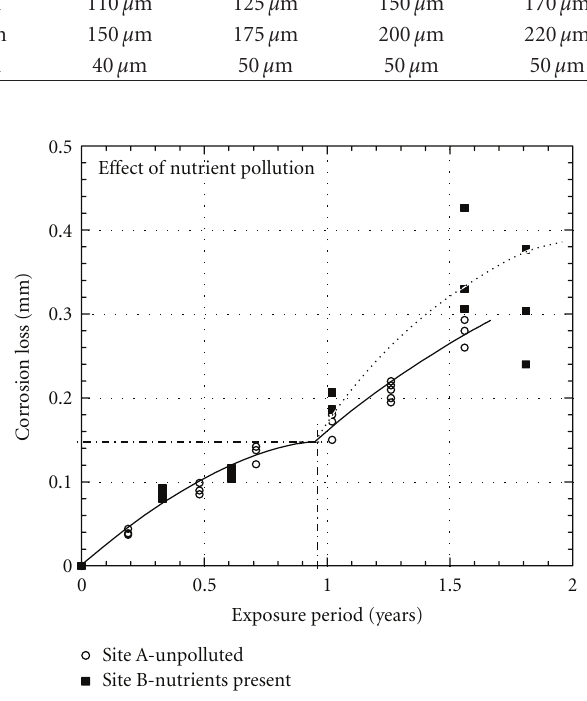
Figure 8: Corrosion loss period of exposure curves for two similar sites, with site B found to have a high nutrient level [12].